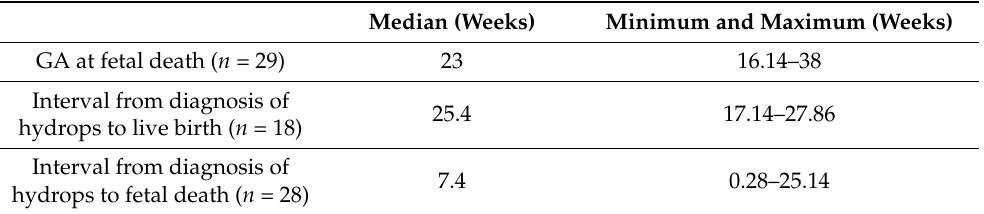
Table 2. Clinical characteristics of cases with documented cardiac activity ≥ 16 weeks with hydrops. Median (Weeks) Minimum and Maximum (Weeks) GA at fetal death ( n = 29) 23 16.14–38 Interval from diagnosis of 25.4 17.14–27.86 hydrops to live birth ( n = 18) Interval from diagnosis of 7.4 0.28–25.14 hydrops to fetal death ( n = 28) Data expressed as median, minimum, and maximum. Gestational Age (GA).